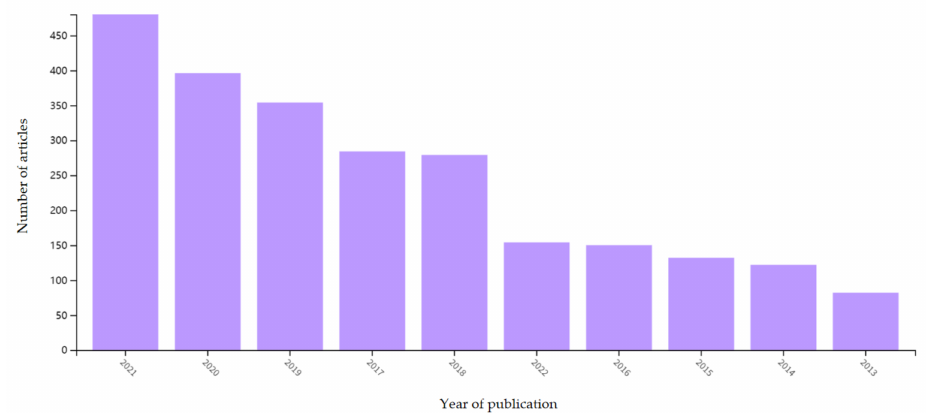
Figure 1. Frequency of publication per